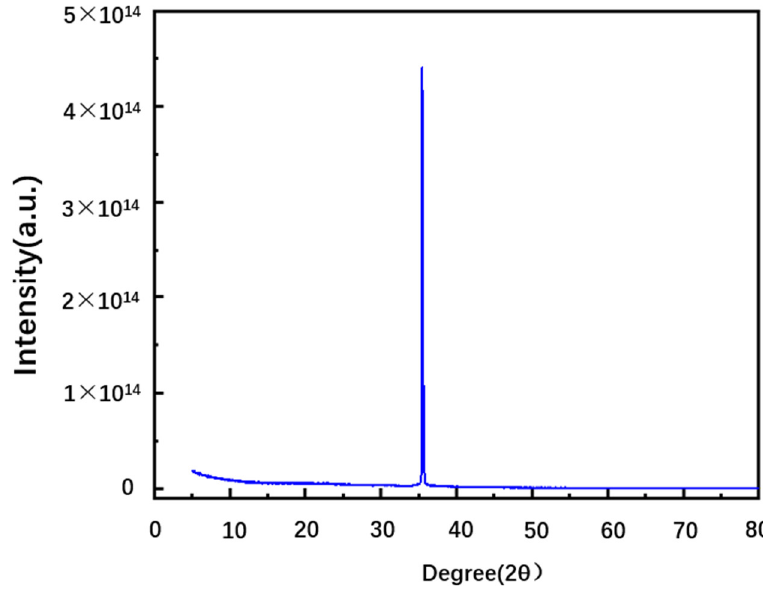
Figure 1. XRD measurement of the pure 4H-SiC sample.